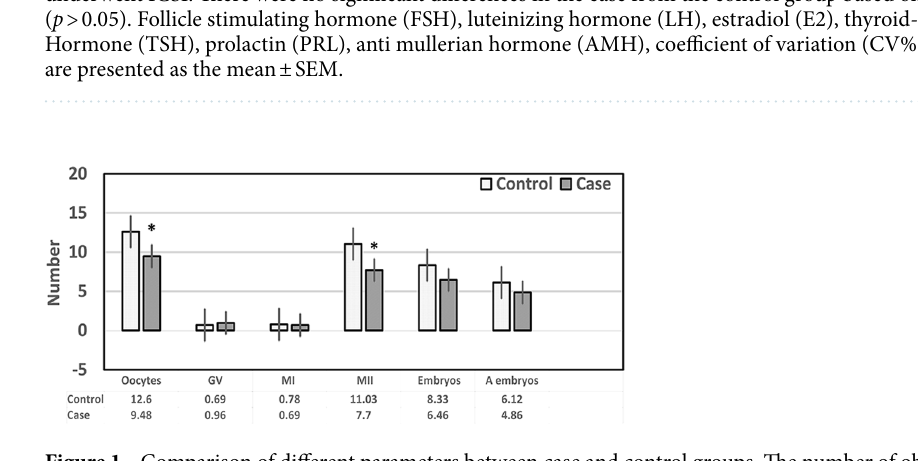
Figure 1. Comparison of different parameters between case and control groups. The number of obtained oocytes, GV, MI, and MII oocytes, the number of embryos, and A-grade embryos were evaluated between the case and control group based on the t-test, * p < 0.05. The results are presented as the mean ± SEM. GV : Germinal Vesicle oocyte, MI : Metaphase I oocyte, MII : Metaphase II oocytes, A Embryo : A-grade